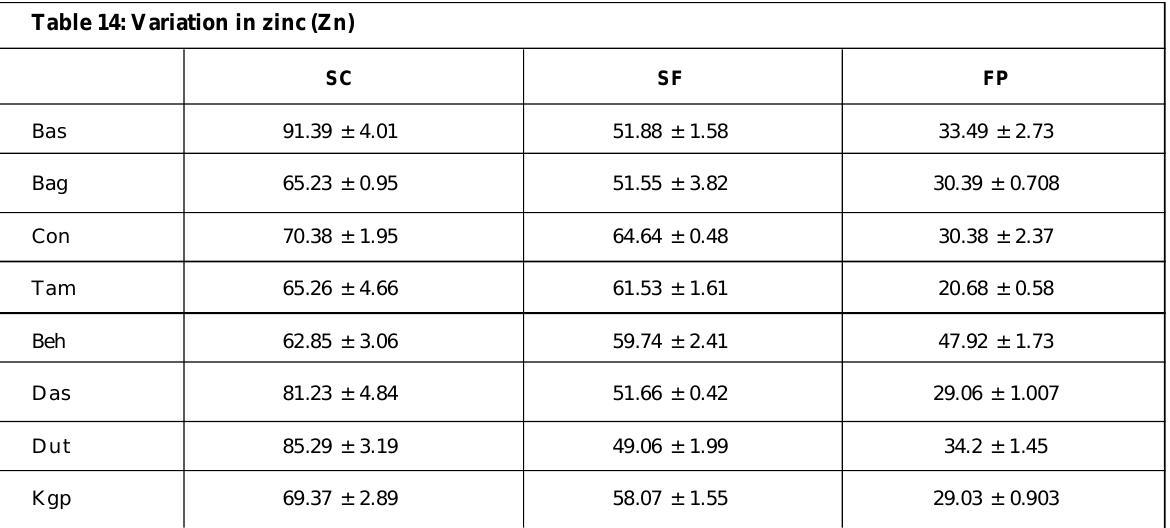
Table 14: Variation in zinc